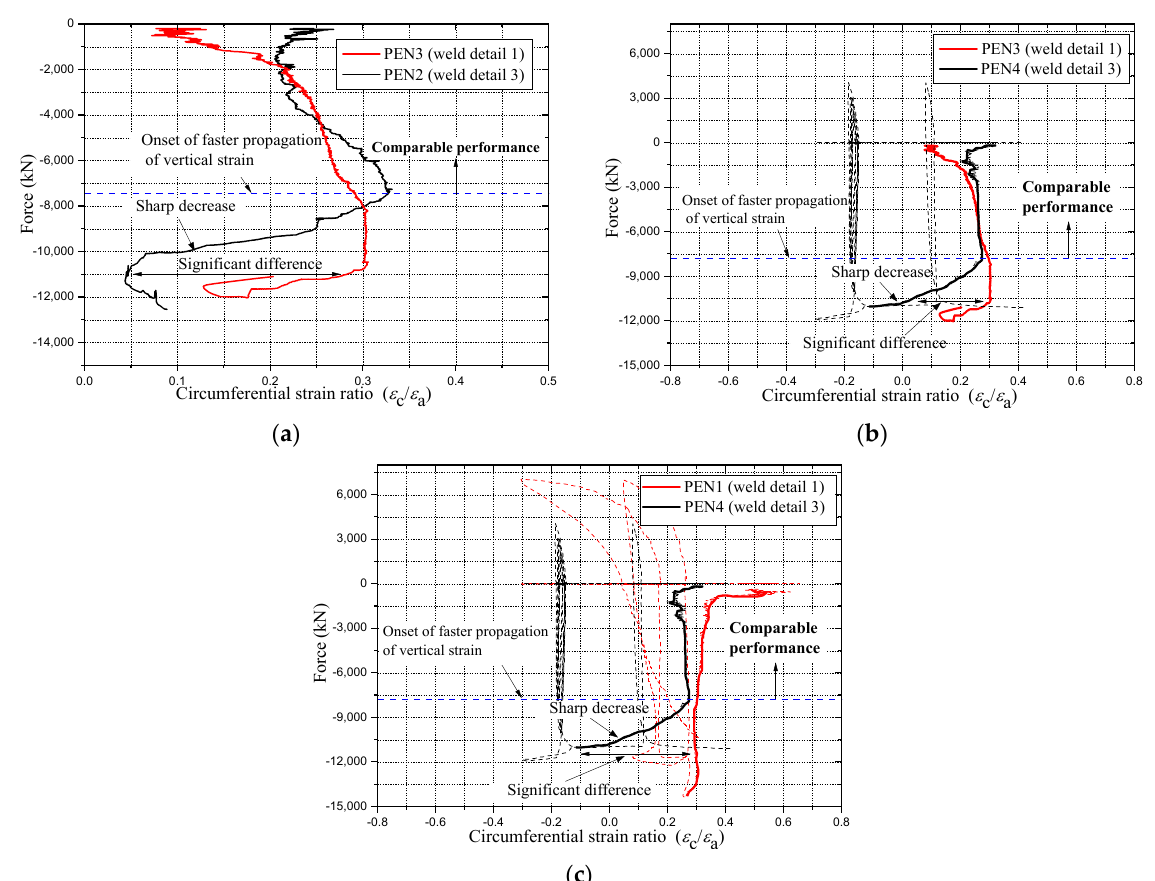
Figure 9. Circumferential strain ratio at the welded corner for different weld details. ( a ) PEN2 vs. PEN3; ( b ) PEN3 vs. PEN4; ( c ) PEN1 vs. PEN4.